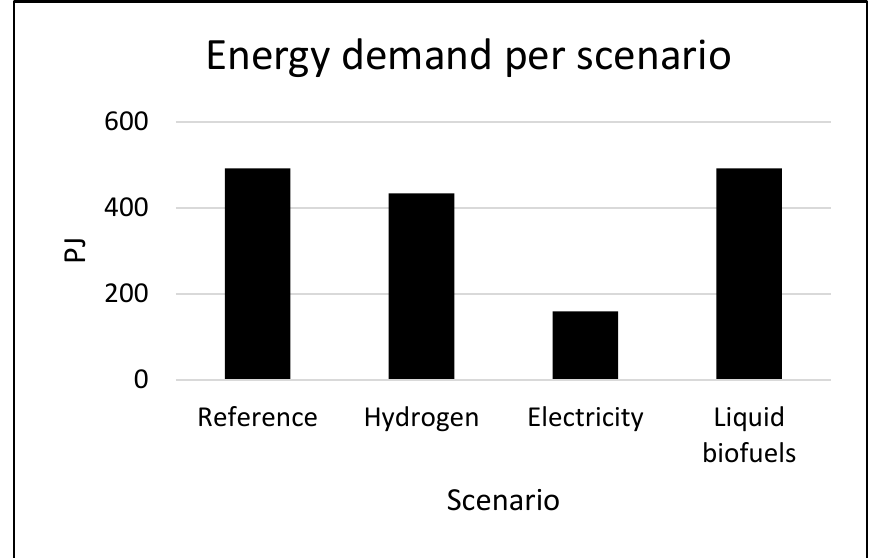
Figure 5. Total energy demand per fuel scenario for the reference situation in the Netherlands in 2016 and scenarios using hydrogen, electricity and liquid biofuels (in petajoules (PJ)).